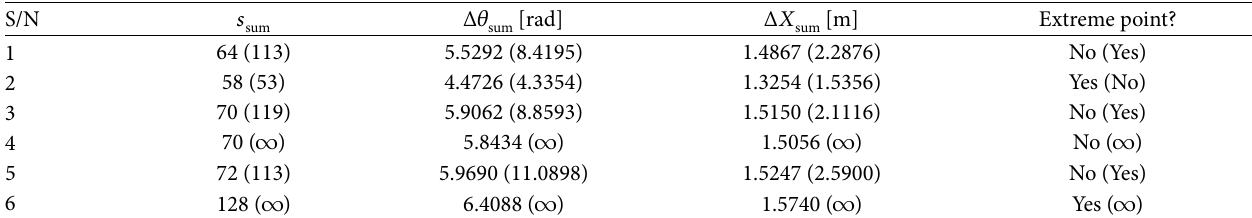
Table 6: Comparison of data between two planning methods for two obstacles.